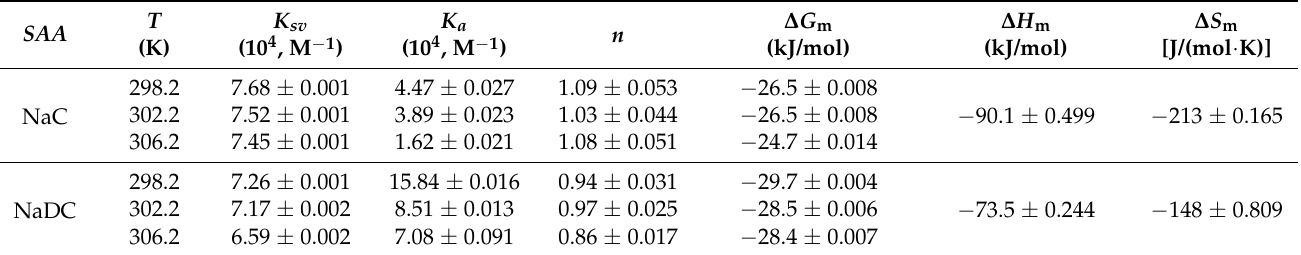
Table 4. Quenching constants, binding constants and thermodynamic constants of the interaction be- tween Hb and CAPE in the presence of NaC or NaDC in pH 7.4 buffer solution at different